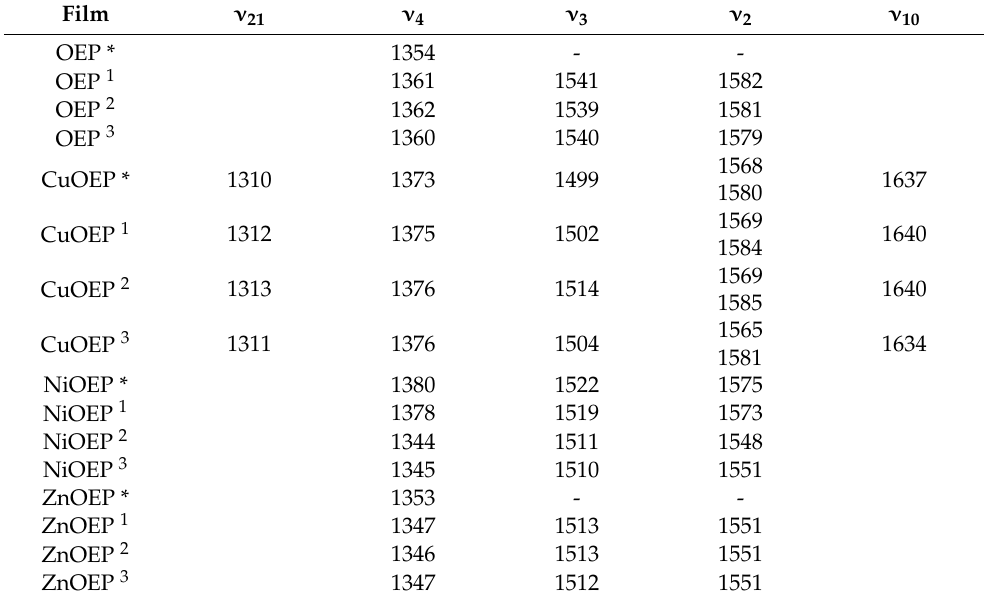
Table 3. Frequencies (cm − 1 ) of selected Raman bands for the polymers/monomers of metallo-octae- thylporphyrins on ITO (excited at 532.0 nm) at the different potential ranges. Film